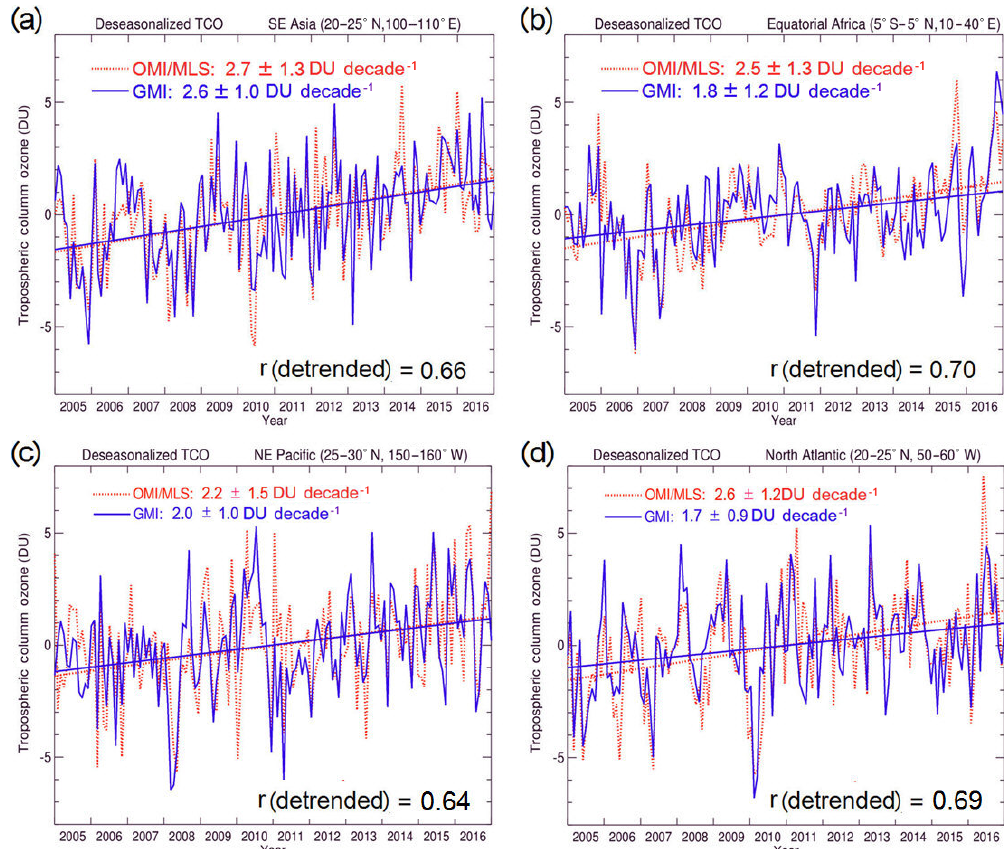
Figure 3. (a) Deseasonalized TCO for OMI/MLS (red, dashed curve) and the MERRA-2 GMI model (blue, solid curve) for SE Asia. Included are MLR regression fits for linear trends and calculated 2 σ values (both in DUdecade − 1 ). Shown at the bottom is the correlation r between the two time series after removing their linear trends. (b) Same as (a) , but for equatorial Africa. (c) Same, but for the NE Pacific. (d) Same, but for the north